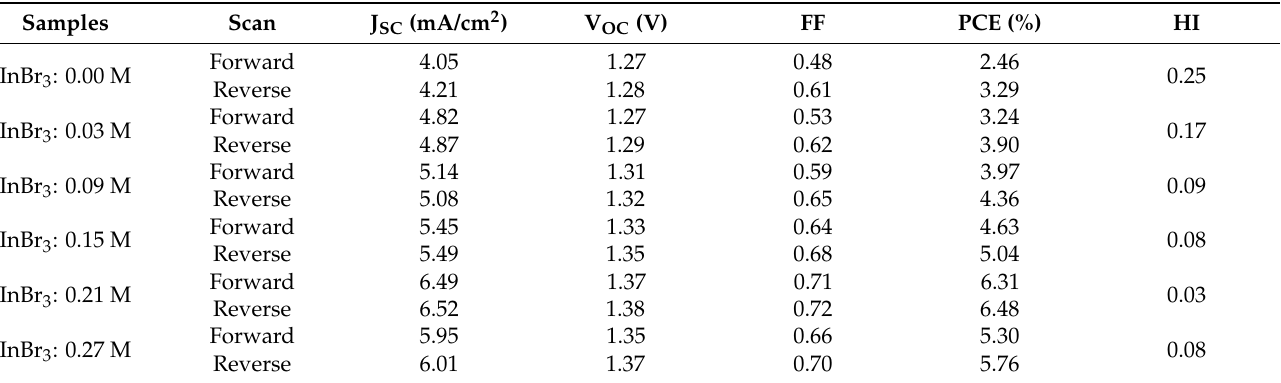
Figure 6. ( a ) Cross-sectional SEM image of the InBr 3 :CsPbBr 3 device, ( b ) J–V characteristics, and ( c ) EQE spectra and integrated photocurrent densities for the InBr 3 :CsPbBr 3 devices. ( d ) Nyquist plots of the pristine CsPbBr 3 and InBr 3 (0.21 M):CsPbBr 3 devices with the equivalent circuit depicted in the inset. Table 1. Key J–V parameters of the InBr 3 :CsPbBr 3 .